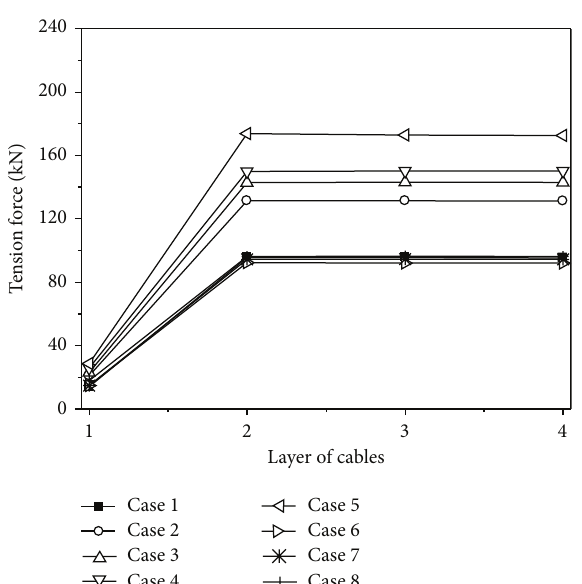
Figure 10: Vertical displacements of the cable under different site conditions. Figure 11: Tension forces of the cables under different site condi-